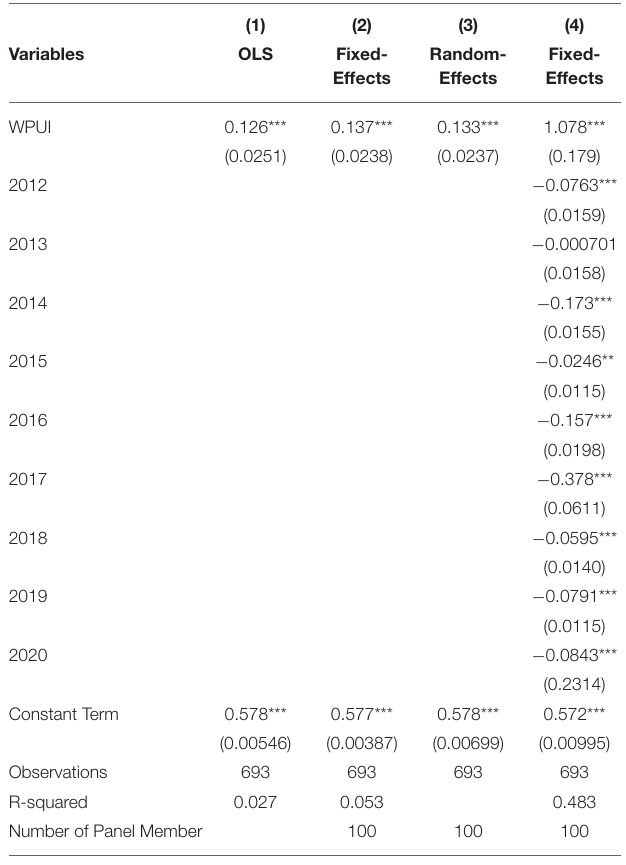
TABLE 2 | Results of the fixed-effects and the random-effects estimations.